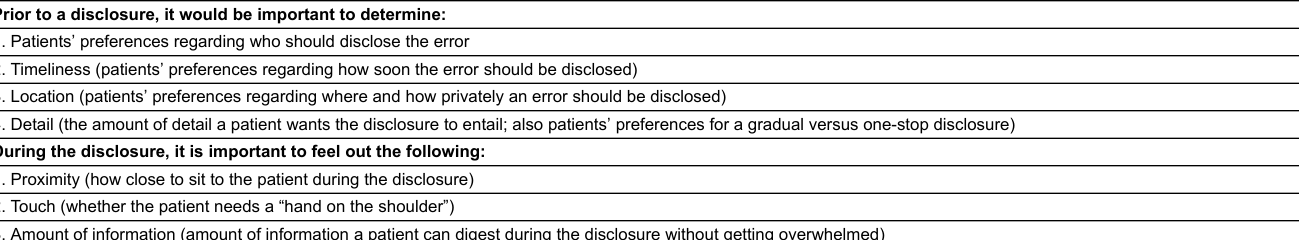
Table 4: Disclosure areas requiring provider’s and institution’s interpersonal adaptation. Prior to a disclosure, it would be important to